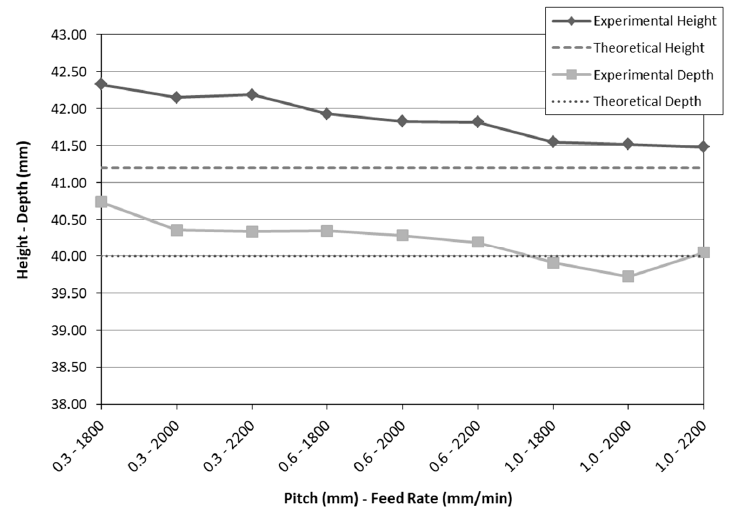
Figure 8. Height and depth of the molds, for different pitches and feed-rates.